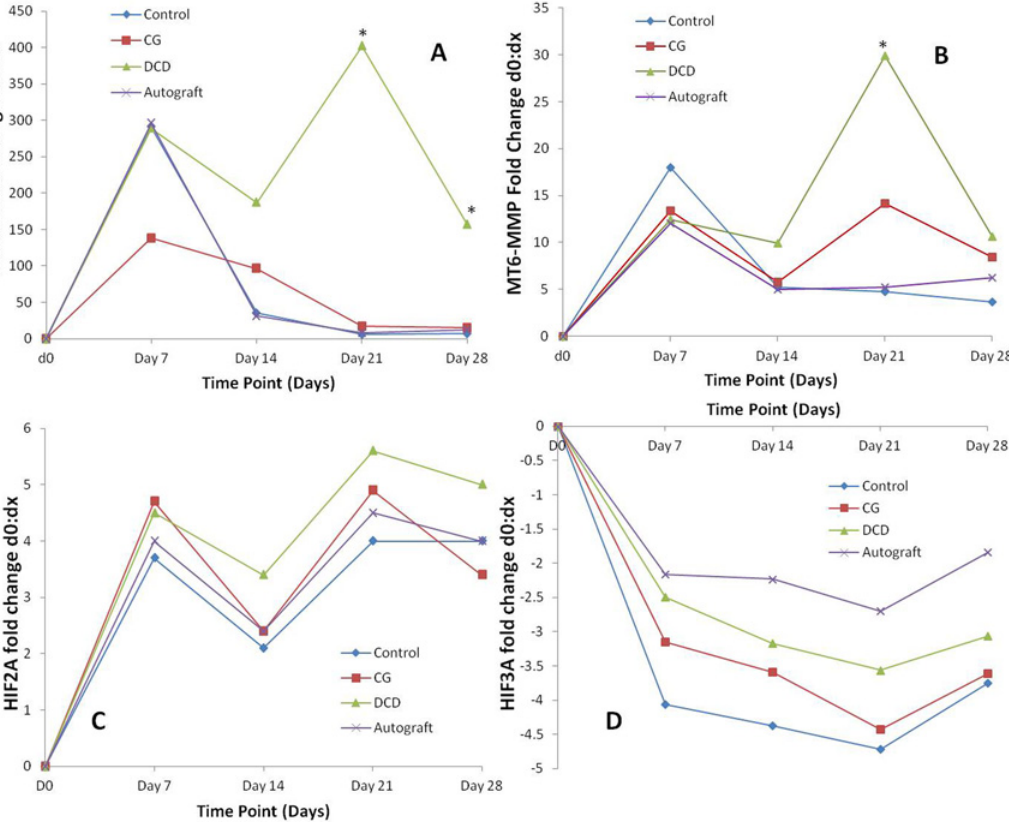
Figure 6. Gene expression profiling. Changes in mRNA expression of prokineticin 2 (PROK2) (n = 5/treatment group) (A), membrane type 6 matrix metalloproteinase (MT6-MMP) (n = 5/treatment group) (B), hypoxia-induced translation factor 2A (HIF2A) (n = 5/treatment group) (C) and hypoxia-induced translation factor 3A (HIF3A) (n = 5/treatment group) (D) after cutaneous wounding derived from qRT-PCR. DCD promotes significant late up-regulation of PROK2 and MT6-MMP. * p < 0.05 indicating significant differences between treatment groups at set time points.